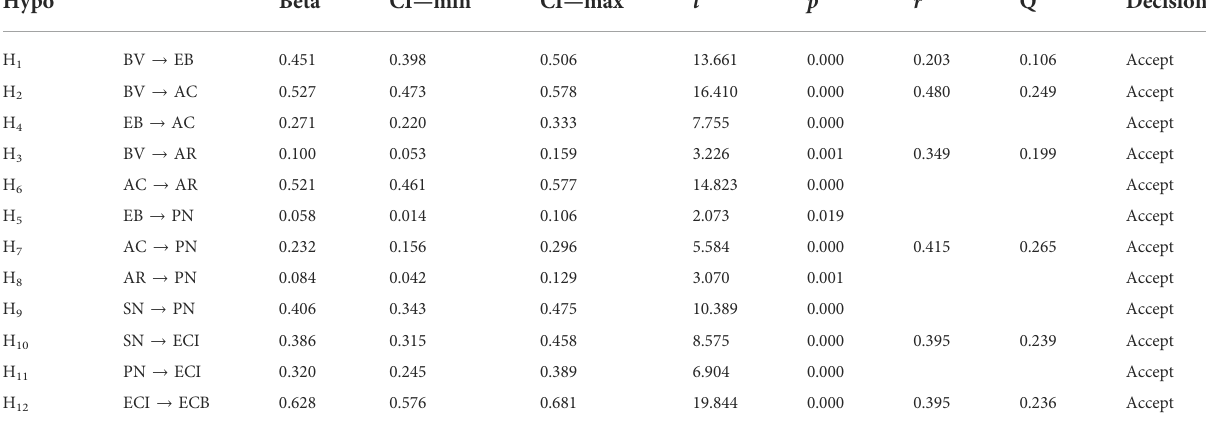
TABLE 6 Path coef fi cients.